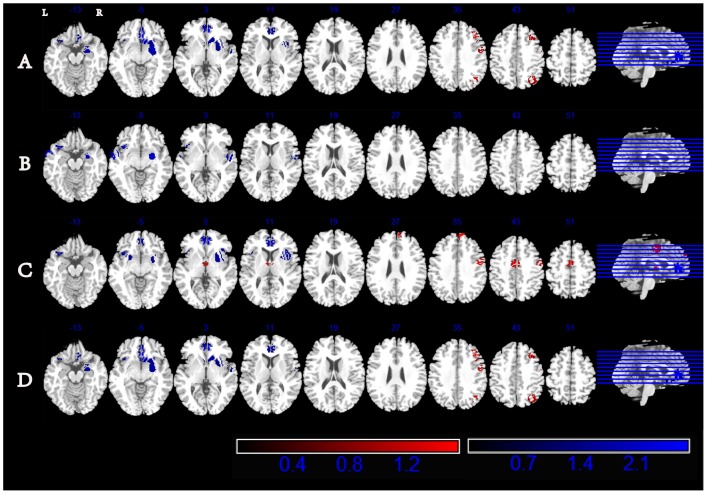
SDM map investigating changes of GMV in anxiety patients comorbid depression (A), anxiety patients without comorbid depression(B), drug-naïve patients(C) and adult patients(D) with axial sections.All coordinates are in the Talairach space and clusters are displayed using the standard ES-SDM thresholds (uncorrected P<0.005, extent threshold of clusters>10 voxels). Areas with increased gray matter relative to controls are displayed in red, and areas with decreased gray matter are displayed in blue. L, left; R, right.